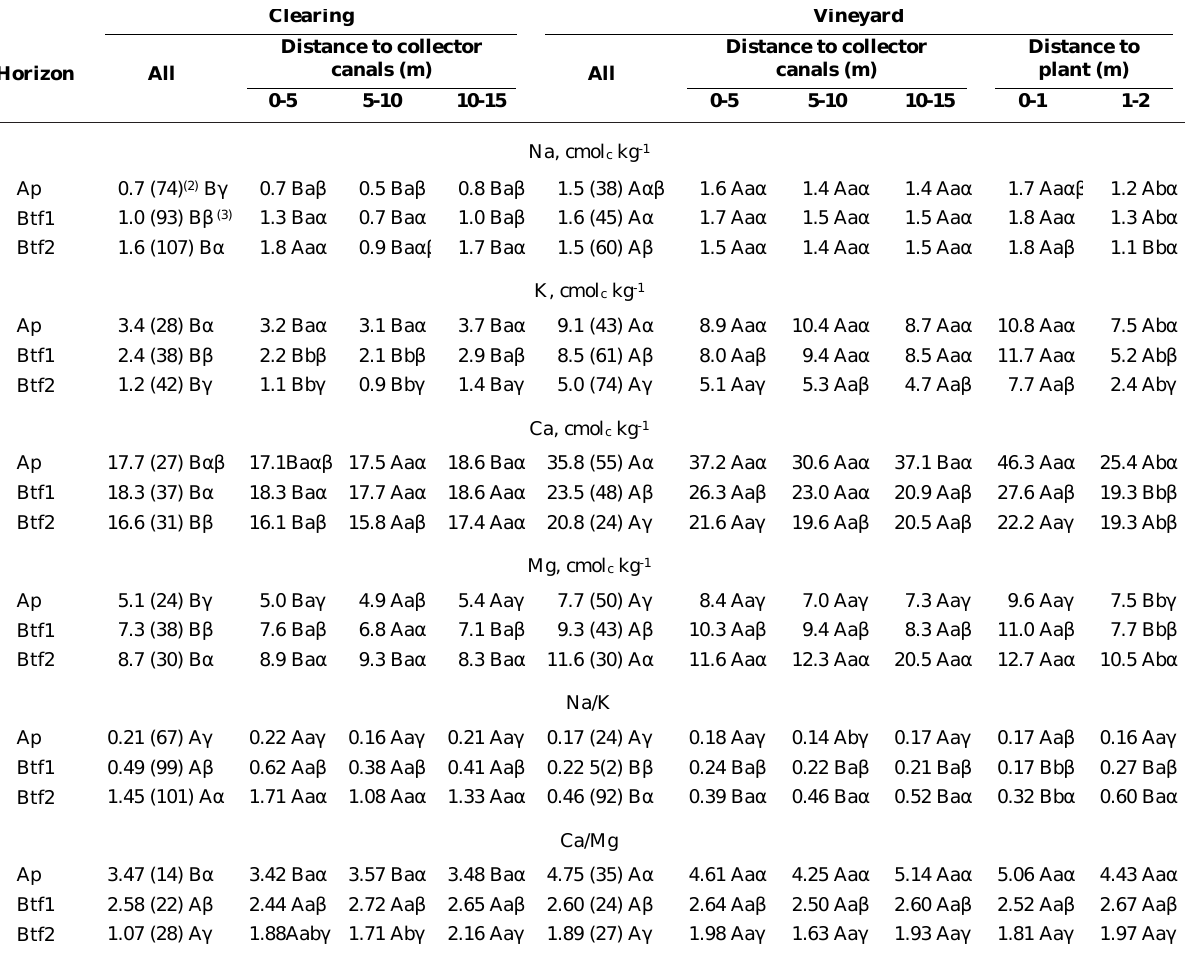
Table 5. Average composition of 1 mol L -1 NH distance to collector canals and plants